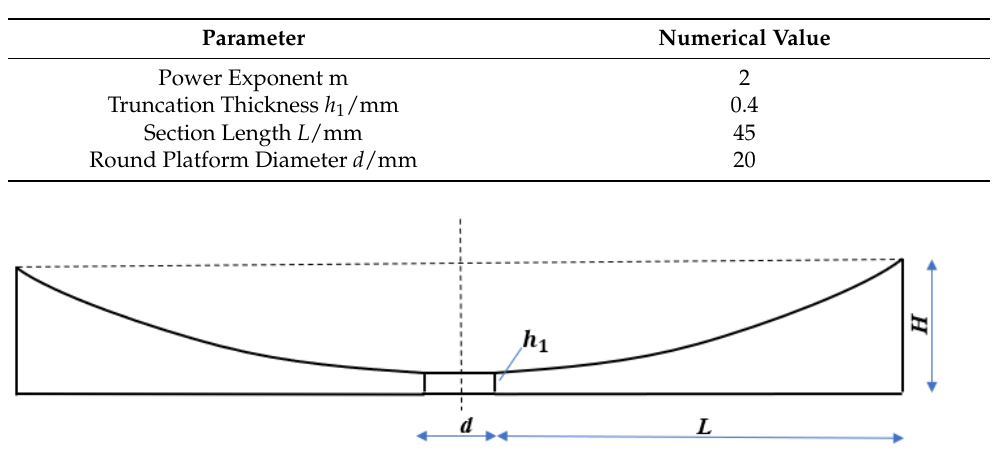
Table 1. Material properties and geometric parameters of the aluminum sheet. Table 2. ABH geometric parameters. Table 2. ABH geometric parameters.